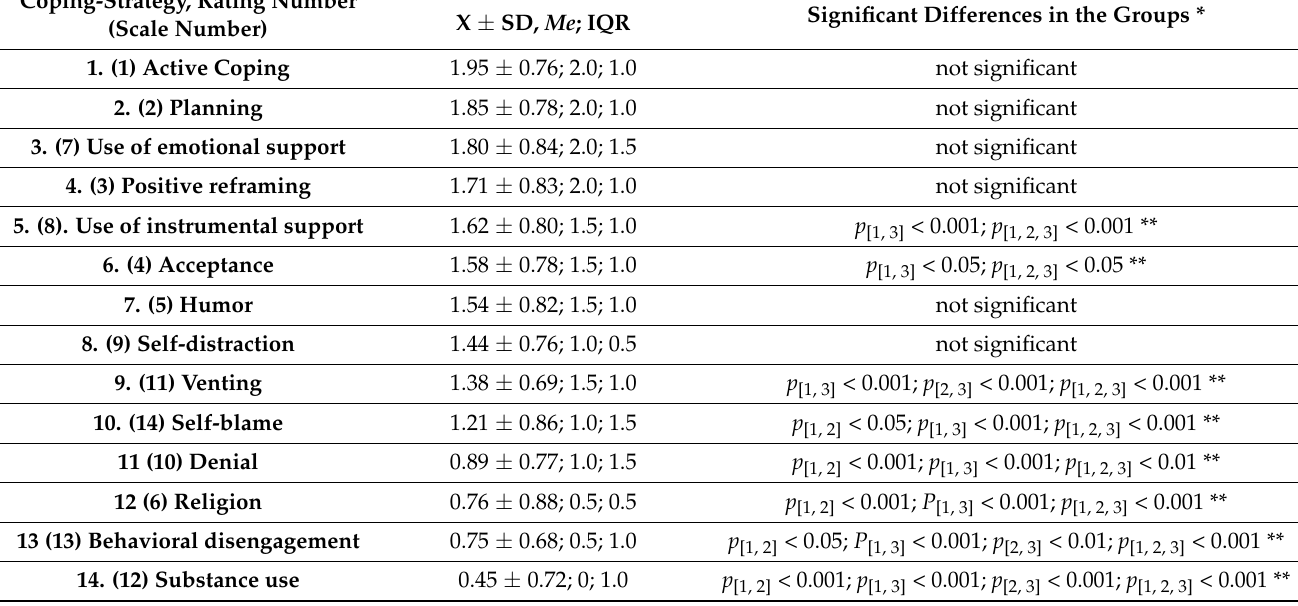
Table 6. Results of the rating choice of the strategies for coping with perceived